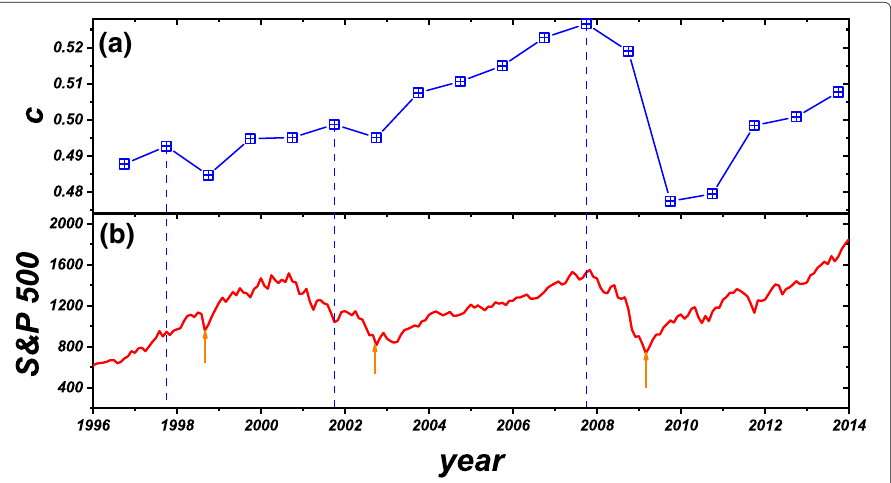
Fig. 4 a Evolution of the clustering coefficient C with years. b The evolution of the S&P 500